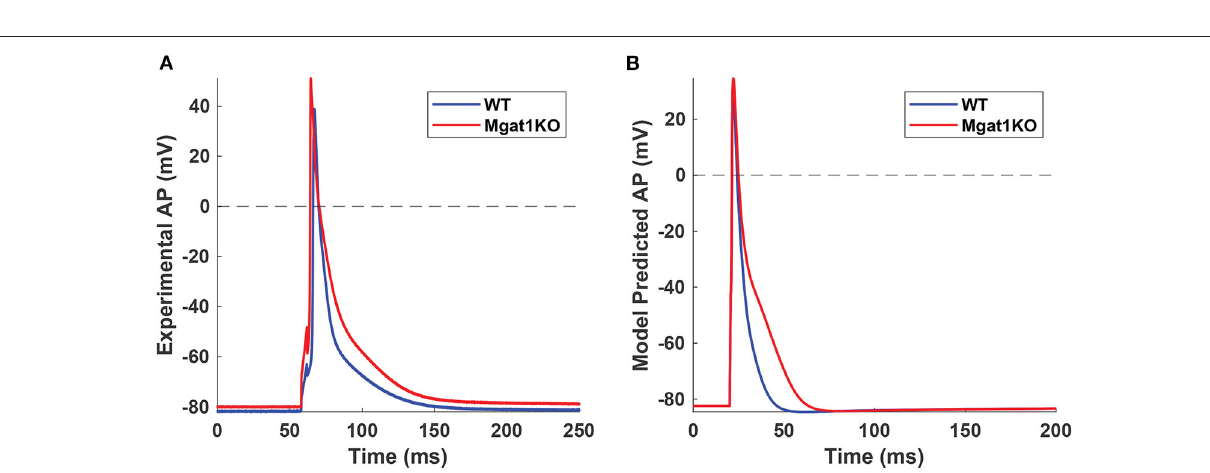
FIGURE 9 | AP traces from WT and Mgat1KO. (A) Experimental data (Ednie et al., 2019b). (B) Model prediction. APs from the Mgat1KO group are significantly prolonged compared to WT in the repolarization